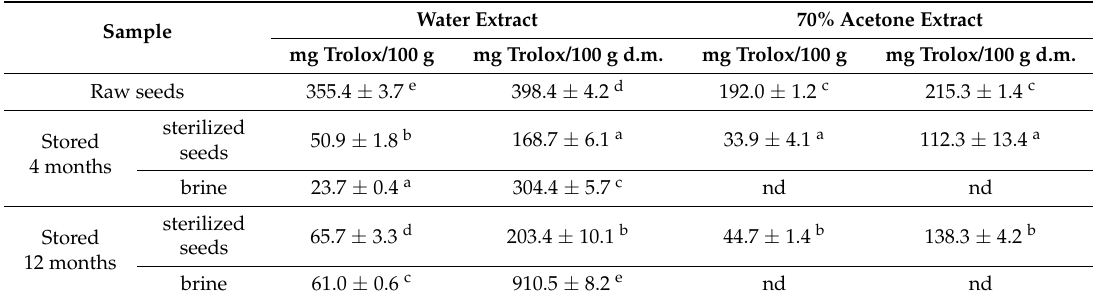
Table 4. Antiradical activities of bean seed extracts and brine against ABTS • + (nd—not determined). Water Sample